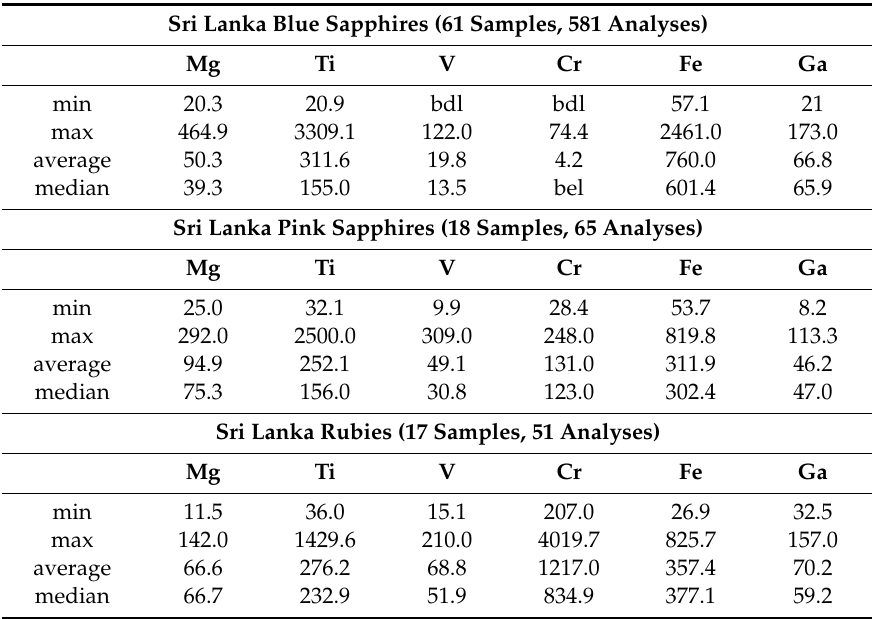
Table 13. Summary of trace elements for Sri Lanka sapphires and rubies in ppm.